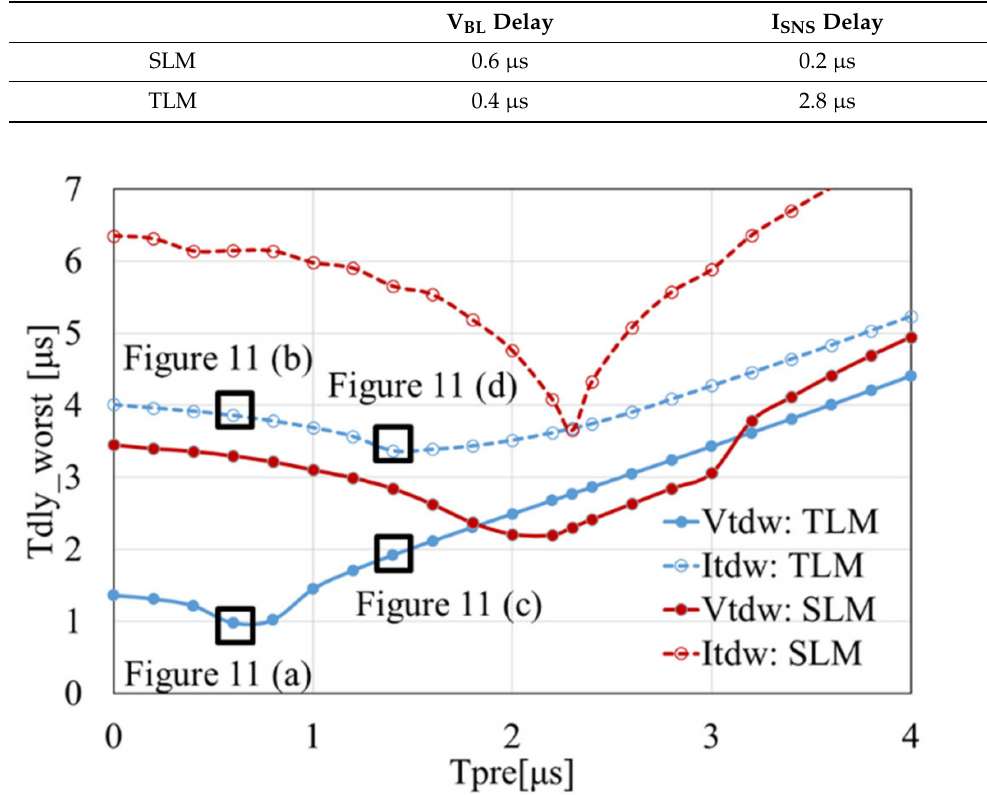
Figure 10. Worst case voltage and current delay (Vtdw/Itdw) with the single-line and three-line models